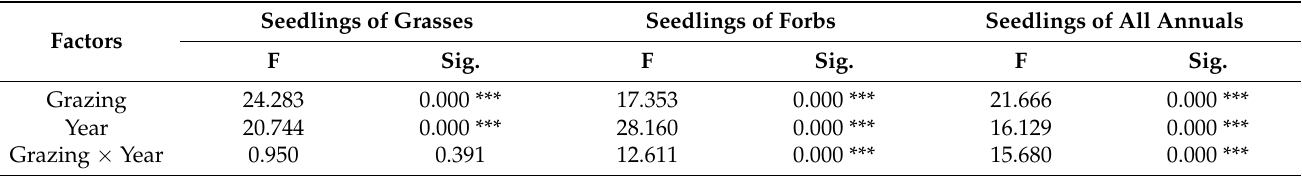
Table 2. F values of two-way ANOVAs of the seedling abundance with grazing and